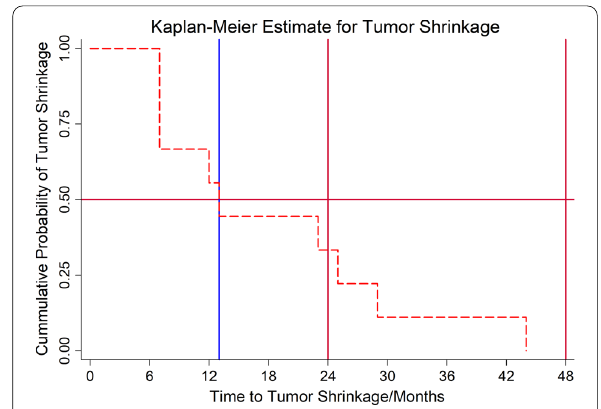
Fig. 2 Kaplan–Meier survival for tumor